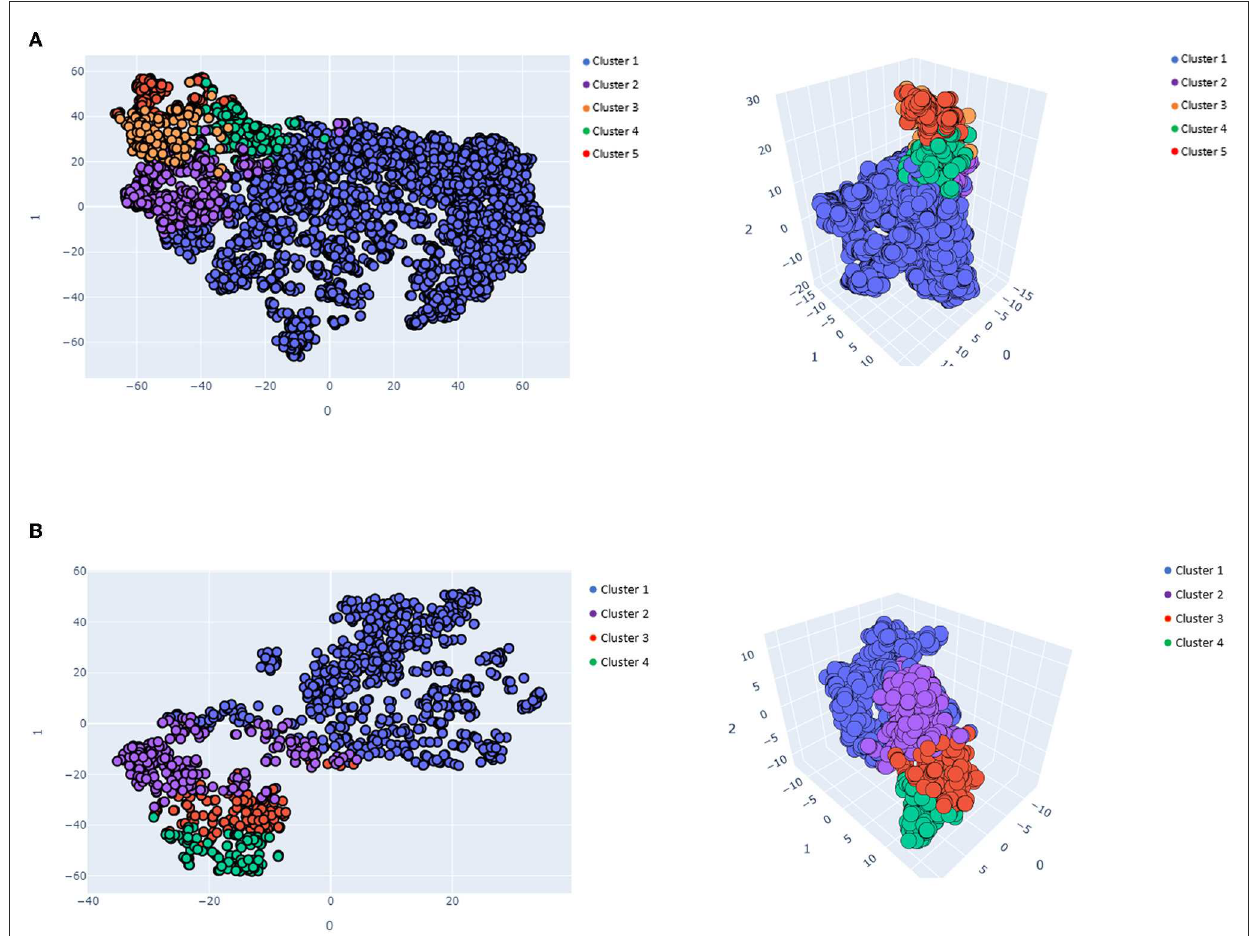
FIGURE2 Visualized K -means clusters results in 2- and 3-dimensional spaces. (A) Visualized ischemic K -means clusters results ( k = 5), (B) Visualized hemorrhagic K -means cluster results ( k =